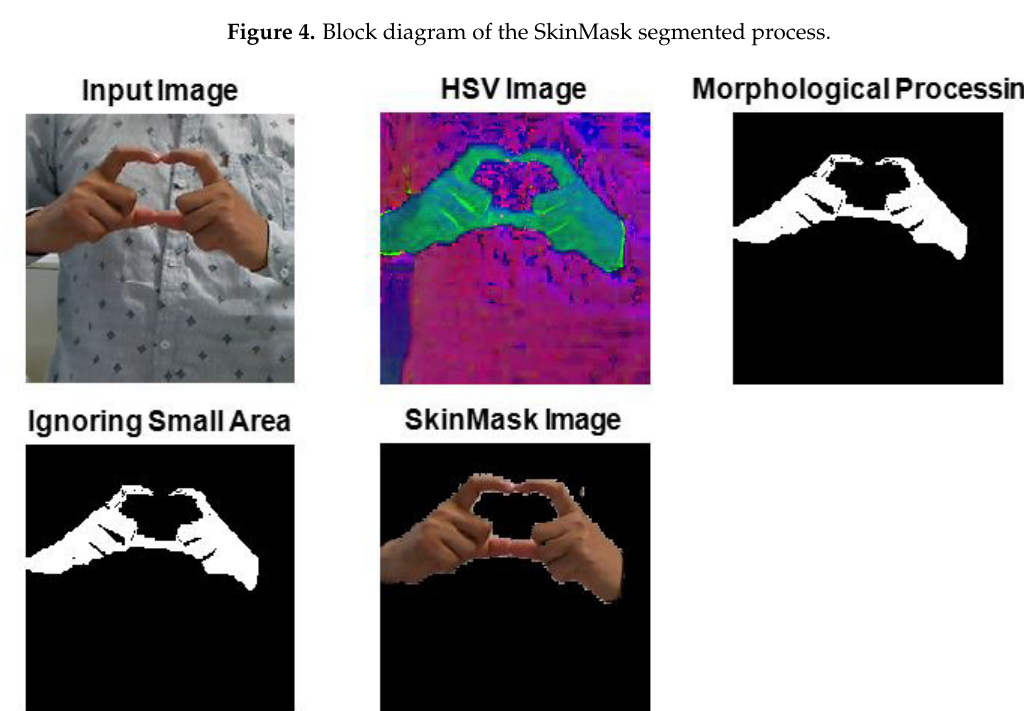
Figure 5. SkinMask segmentation process of an input